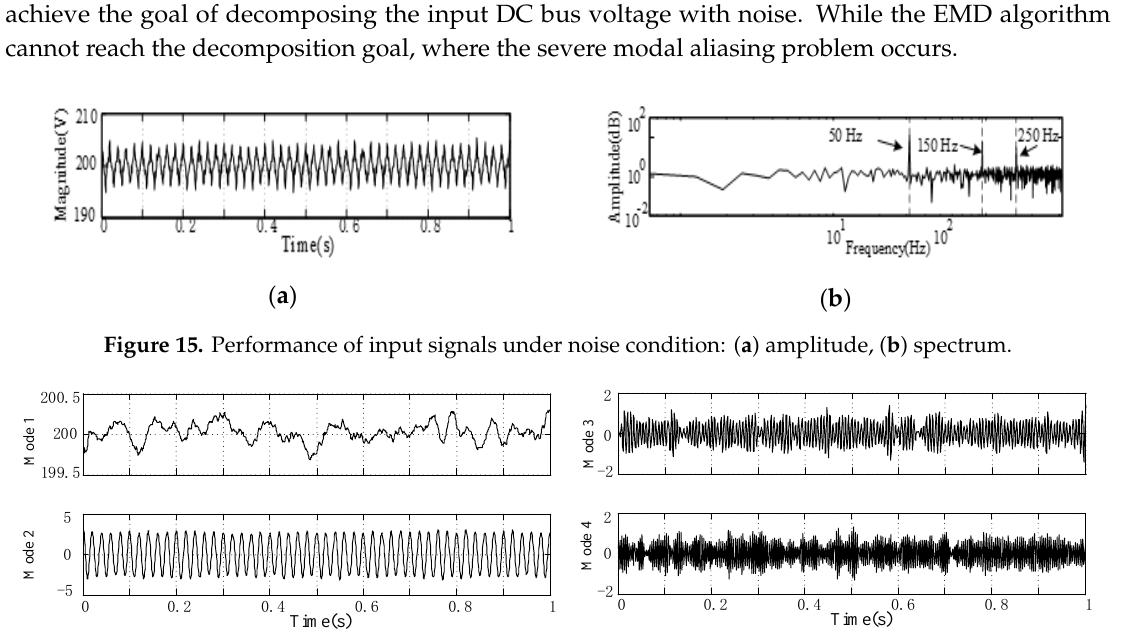
Figure 16. The decomposed modes of VMD-HT algorithm.